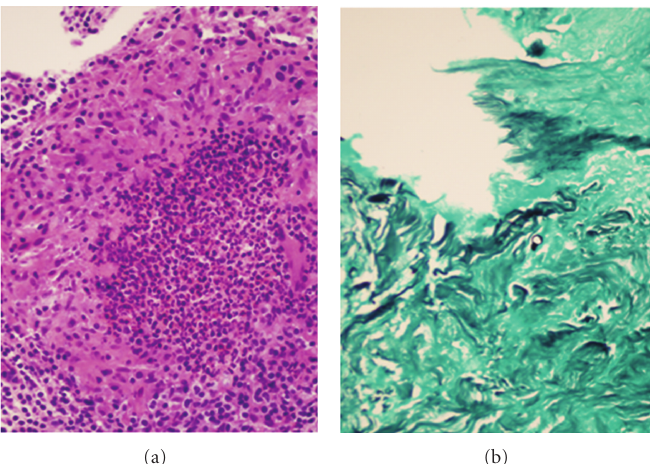
Figure 2: (a) Hematoxylin and eosin (H&E) stain from the second debridement demonstrating granulomatous inflammation. (b) Gomori methenamine silver (GMS) stain from the second debridement demonstrating broad-based budding yeast or “baby bottle” morphology of Blastomyces dermatitidis .